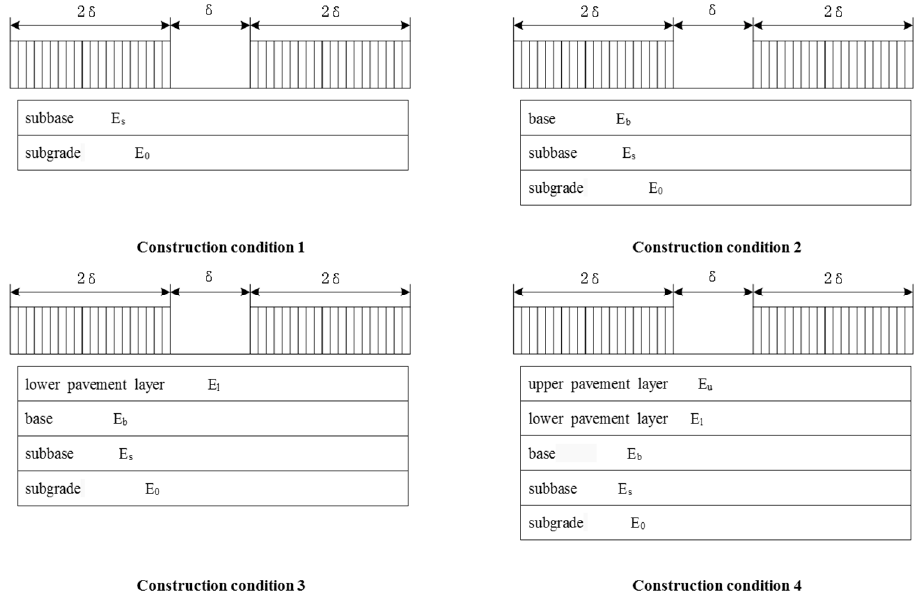
Figure 12. Pavement conditions model for different construction periods.